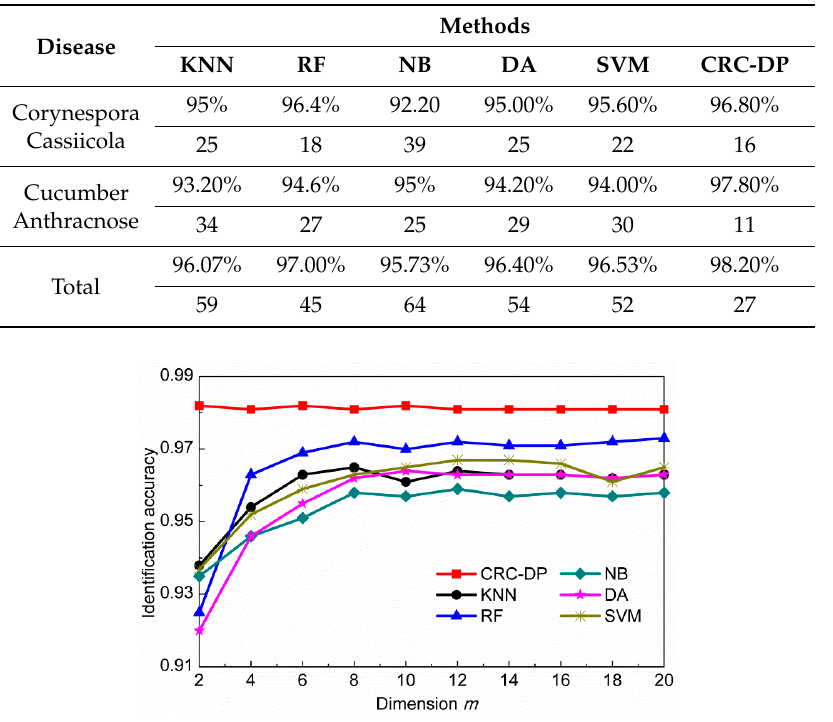
Figure 6. The identification accuracy versus the reduced sample dimension m . Table 2. Mean online identification time of each query sample for three-class classification.